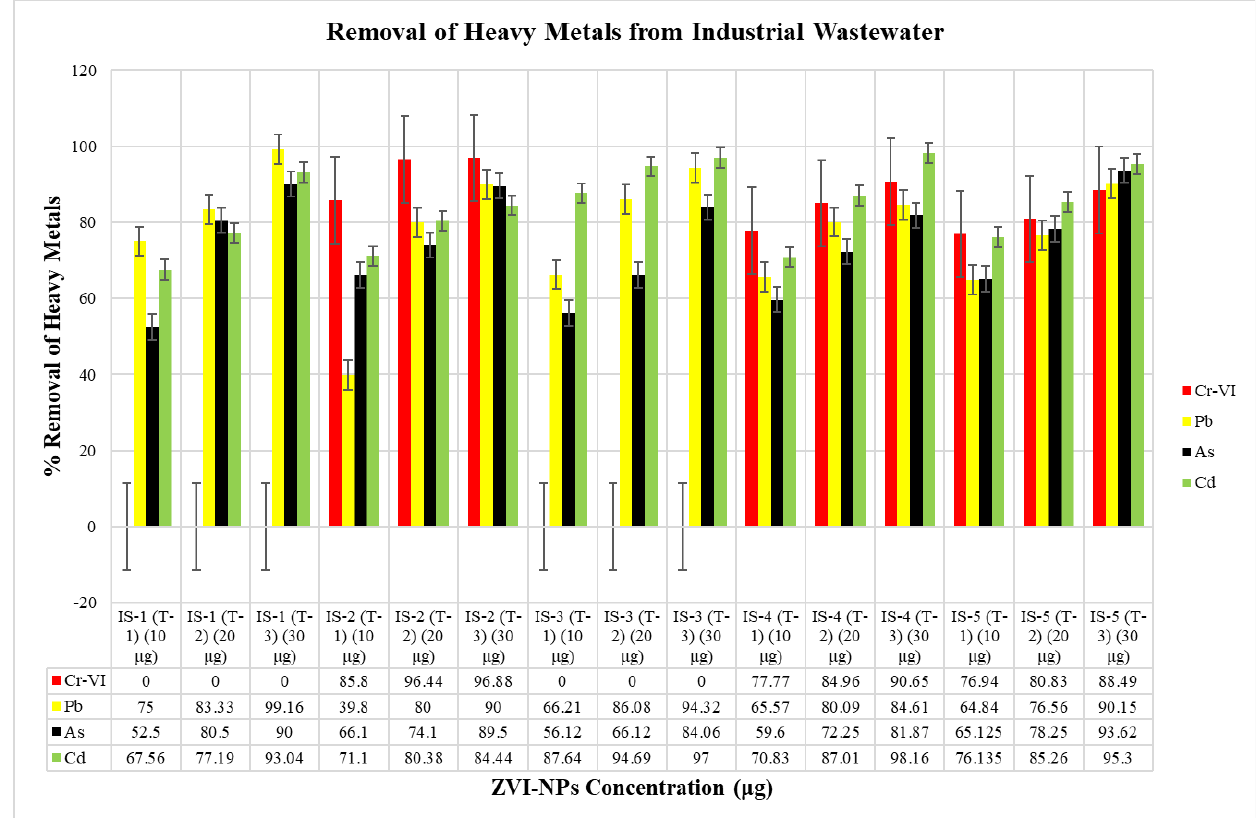
Figure 7 . Graphical representation of the remediated heavy metals (Cr - VI, Pb, As , and Pb) from 100 Figure 7. Graphical representation of the remediated heavy metals (Cr-VI, Pb, As, and Pb) from mL of industrial wastewater at respective concentrations of ZVI - NPs (10 µ g, 20 µ g , and 30 µ g). 100 mL of industrial wastewater at respective concentrations of ZVI-NPs (10 µ g, 20 µ g, and 30 µ g). Table 3. Final concentrations of heavy metals detected after treatment of industrial wastewater by 2.7. Anti-Inflammatory Analysis of ZVI-NPs ZVI - NPs.